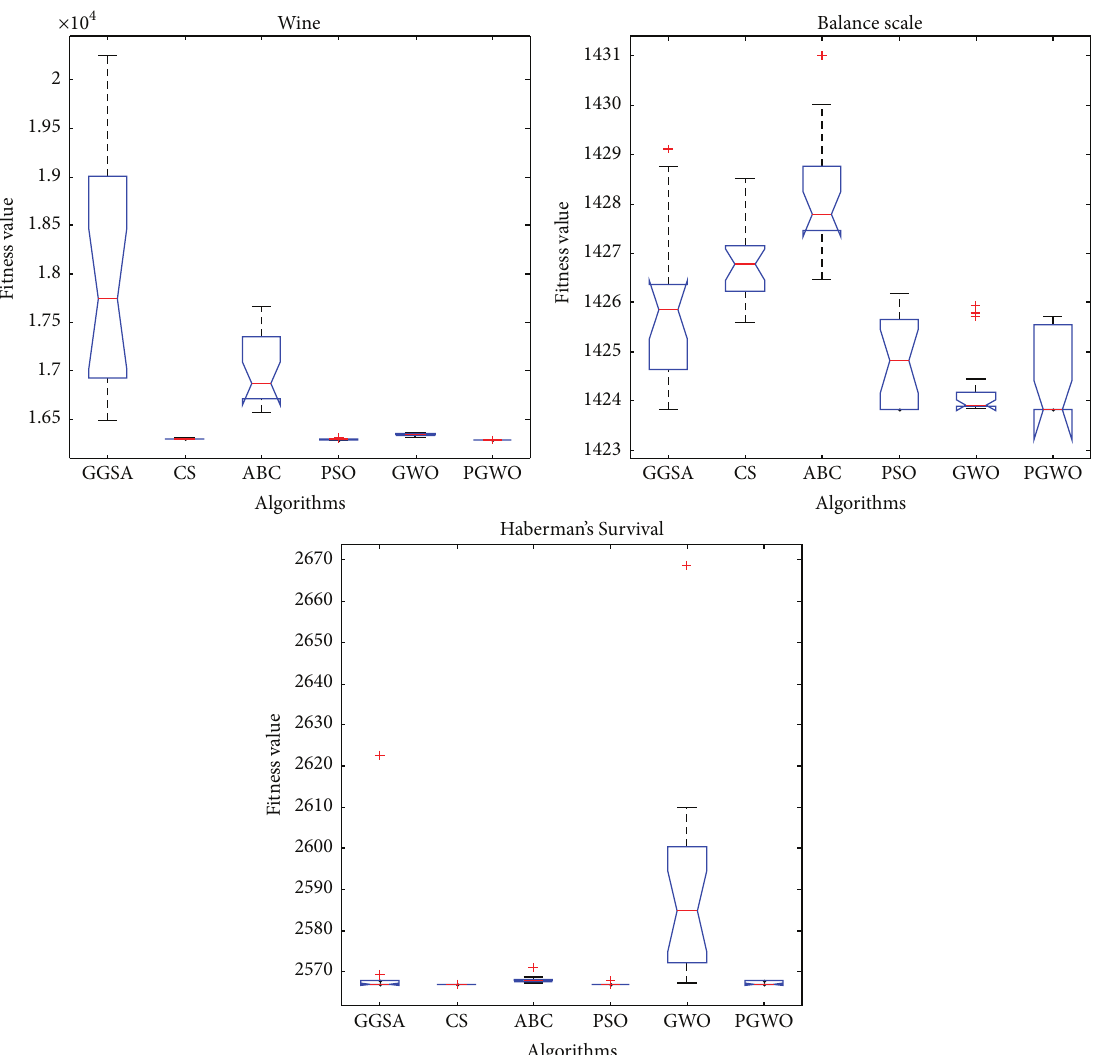
Figure 3: ANOVA tests of clustering on data sets over 20 independent